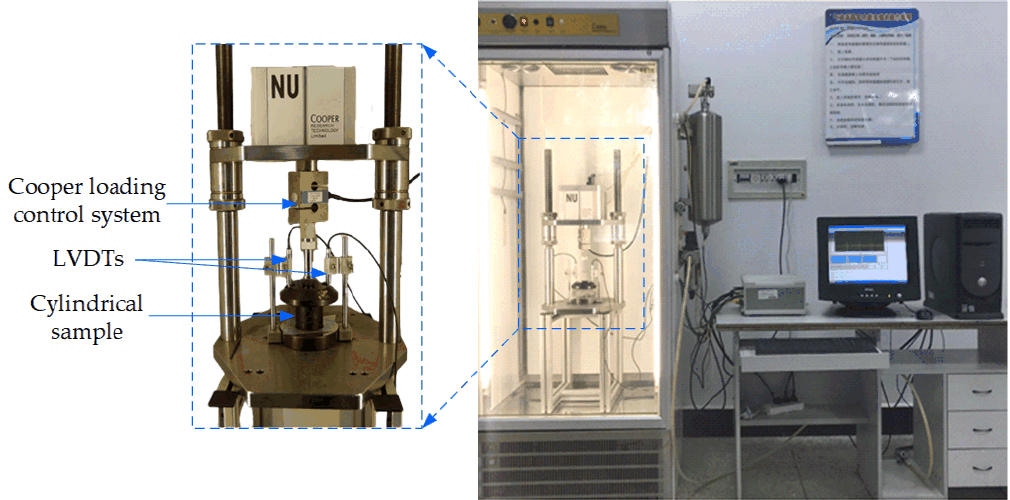
Figure 3. Uniaxial static compression creep test by Cooper NU-14 used in this paper.